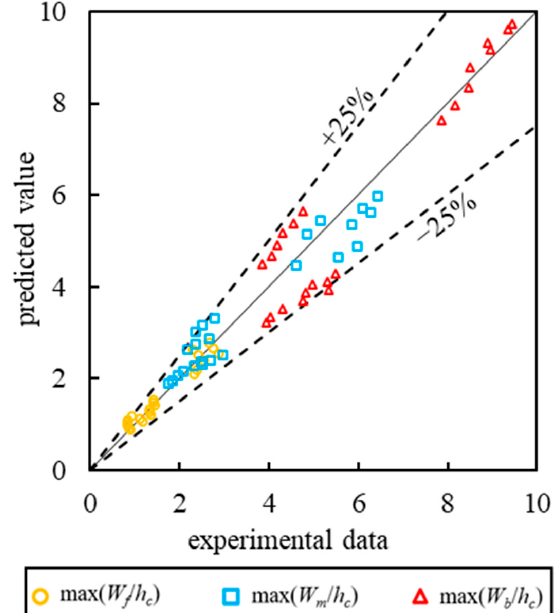
Figure 11. Comparison of predicted max( W f / h c ), max( W m / h c ) and max( W b / h c ) from Equations (5)–(7) with experimental data in Figure 10.